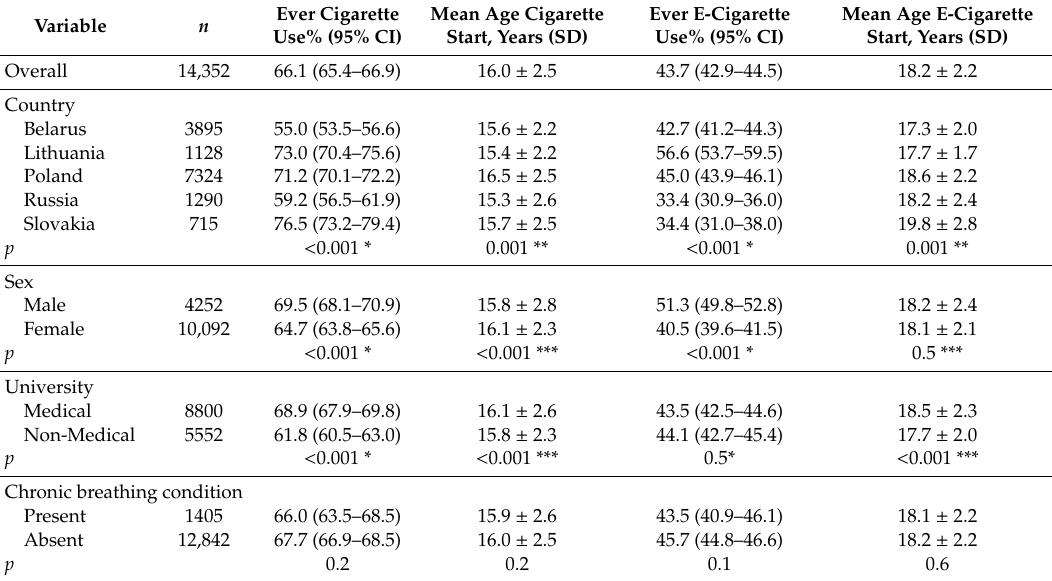
Table 2. Prevalence of ever using a traditional cigarette or e-cigarette and mean age of first